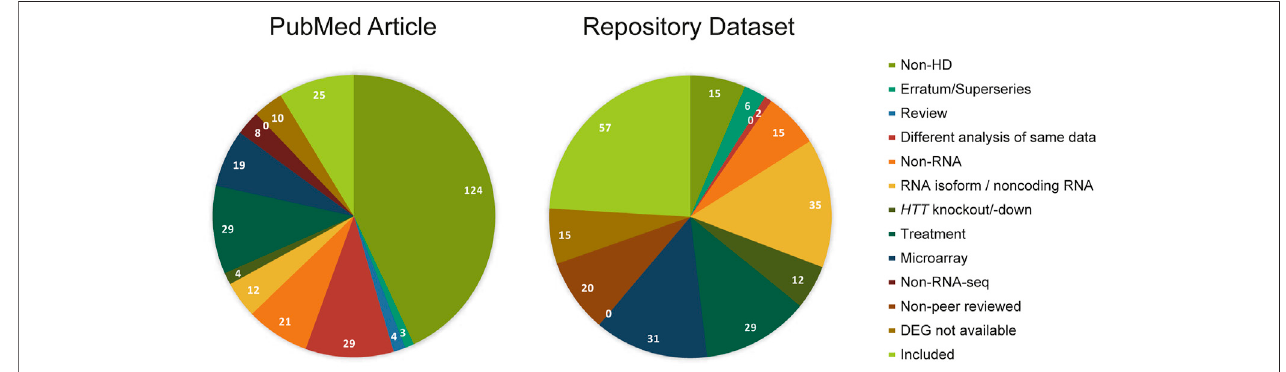
FIGURE 1 | Studies screened from PubMed and dataset repositories. PubMed articles and repository datasets are screened with the same exclusion criteria in decreasing order of priority: non-HD, erratum (Pubmed)/superserie entries (repository dataset), review, different analysis of same data, non-RNA, RNA isoform/ noncoding RNA, HTT knockout/down, treatment, microarray, non-RNA-seq, and no DEG analysis. The numbers of PubMed articles or repository datasets in each category are indicated.